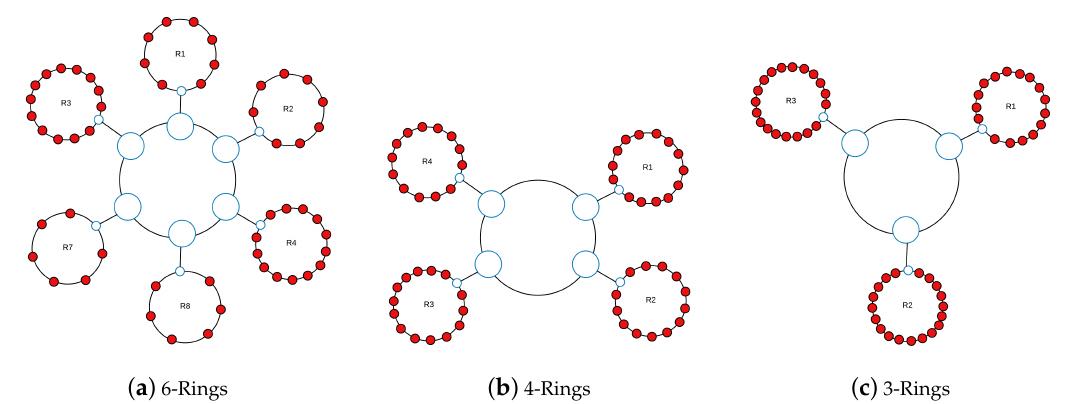
Figure 16. Considered Multiple-Ring Topologies for the Avionics Case Study.